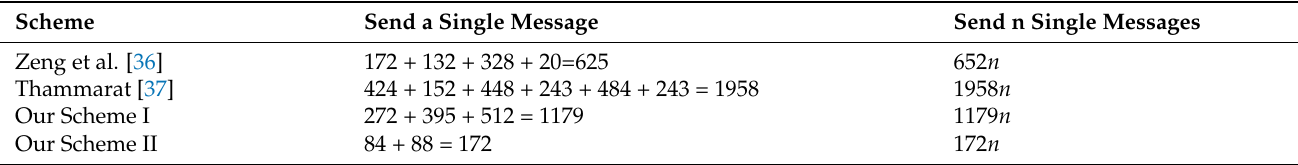
Table 8. Comparison of communication costs (in